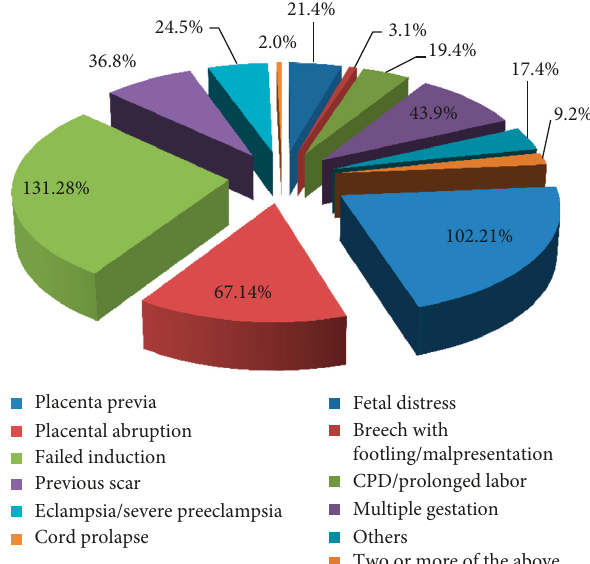
Figure 2: Indications for cesarean section at selected health institutions, July 2015–June 2016 ( n